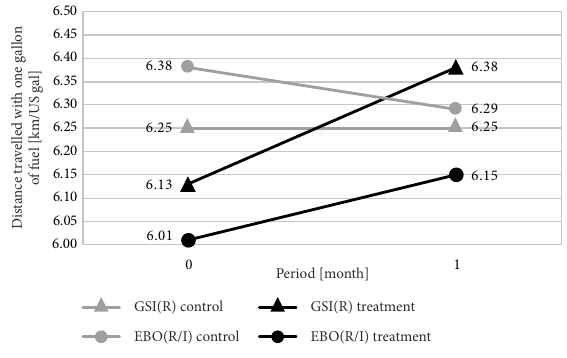
Figure 3. Distance travelled with one gallon of fuel for periods 0 (baseline) and 1 (month 1 post-test) Table 2. Distance travelled in km with one gallon of fuel (month